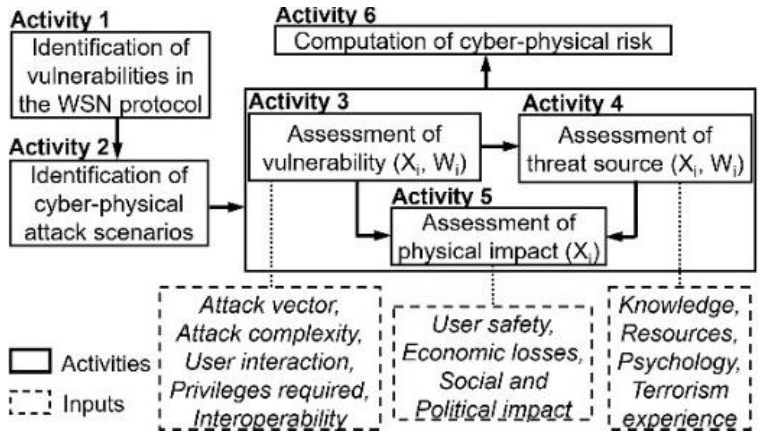
Figure 1. Overview of cyber-physical risk assessment approach .